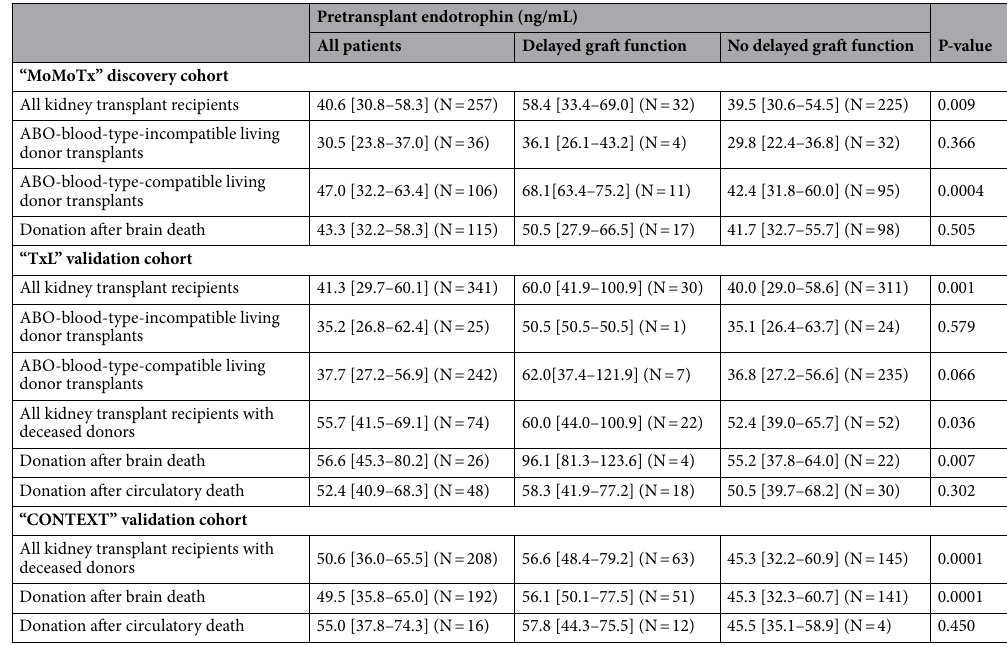
Table 2. Pretransplant plasma endotrophin in kidney transplant recipients in the discovery cohort and in the validation cohorts who were stratified according to delayed graft function. Delayed graft function was defined by at least one dialysis within the first week after transplantation. Continuous data are presented as median (interquartile range). Groups containing continuous data were compared using Mann–Whitney